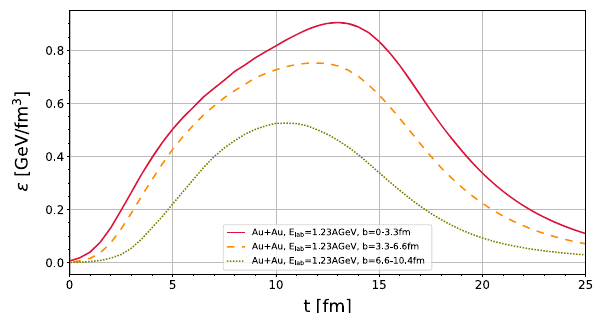
Fig. 5 Time evolution of the energy density in the center of the system for Au+Au collisions at E lab = 1.23 AGeV, 0–5%, 5–20% and 20–50% centrality classes